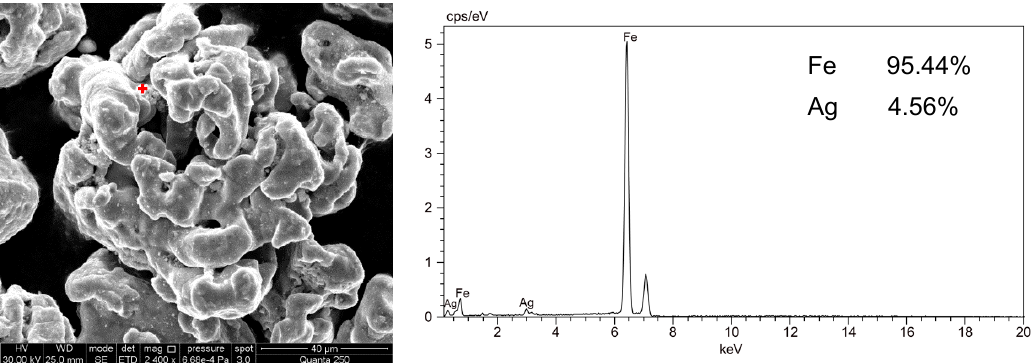
Figure 1. SEM image and EDS of fresh Ag/Fe particle with 1.0 wt.% Ag loading.